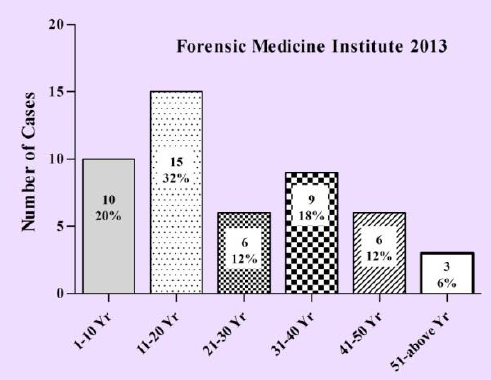
Figure (5): Distribution of poisoning